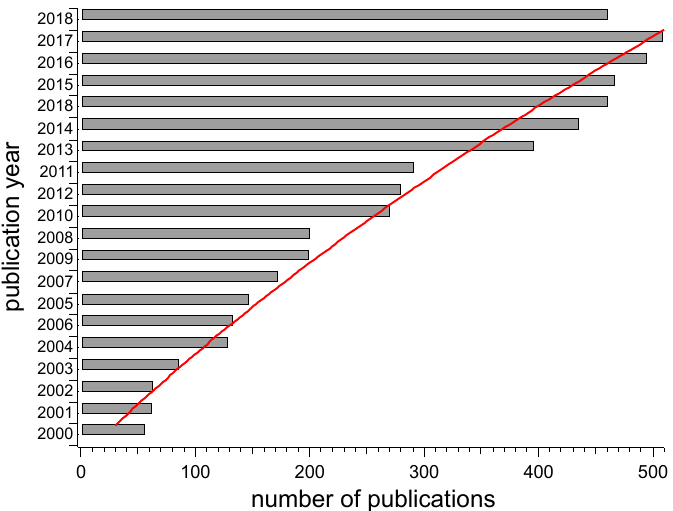
Figure 1. Number of publications in the field of smart and modern thermoplastics since 2000 and growing trend (red line). Source: CAS SciFinder ® Scholar, October 2018.